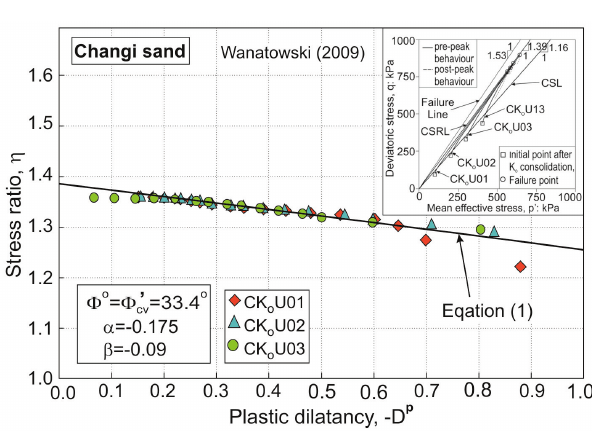
Fig. 10. Stress ratio-plastic dilatancy relationship for the strain-hardening behaviour of Changi sand